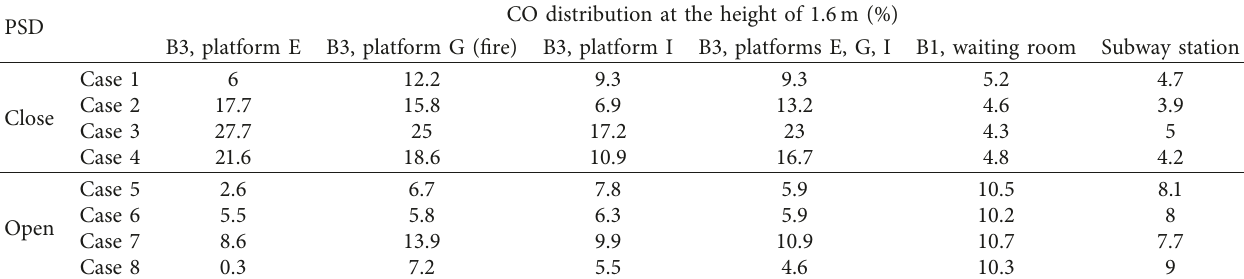
Table 3: CO distribution of the underground subway station at the height of 1.6m.